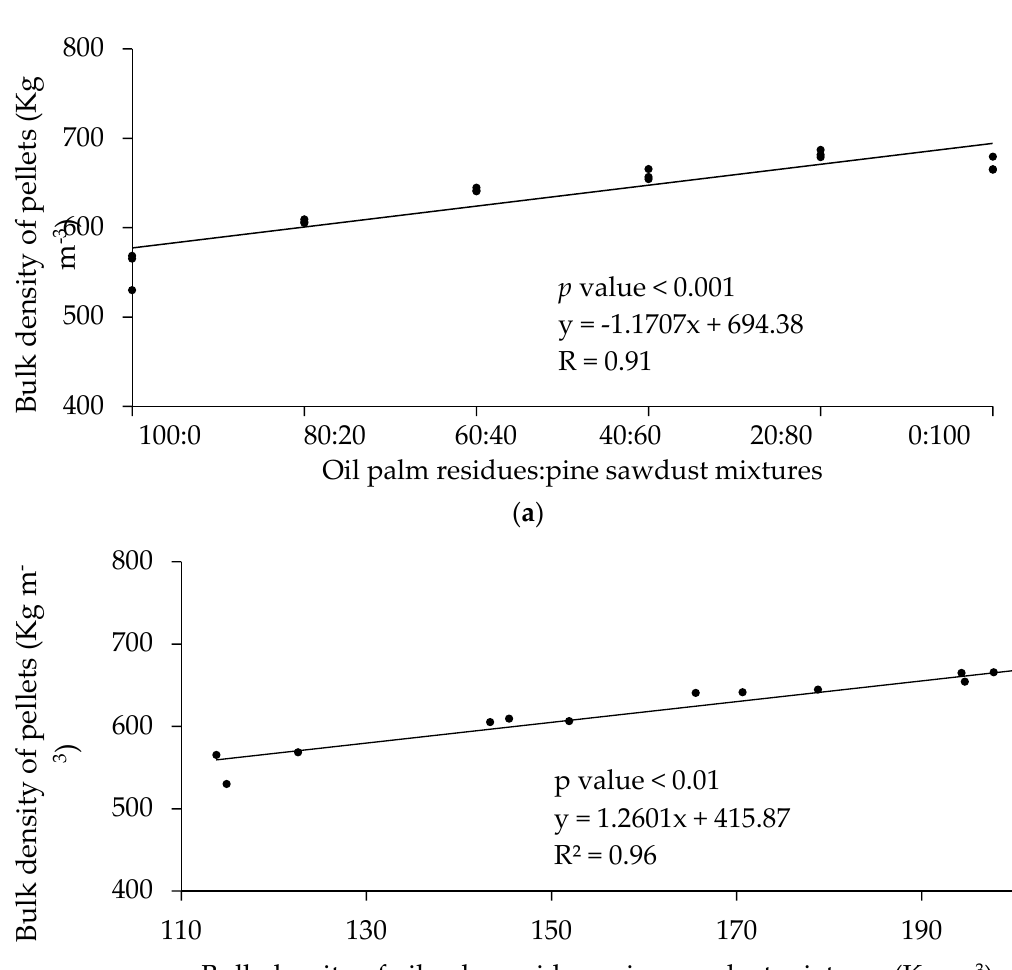
( d ) Figure 1. Relationship of agro-pellet bulk density with chemical components. ( a ) Cellulose; ( b )